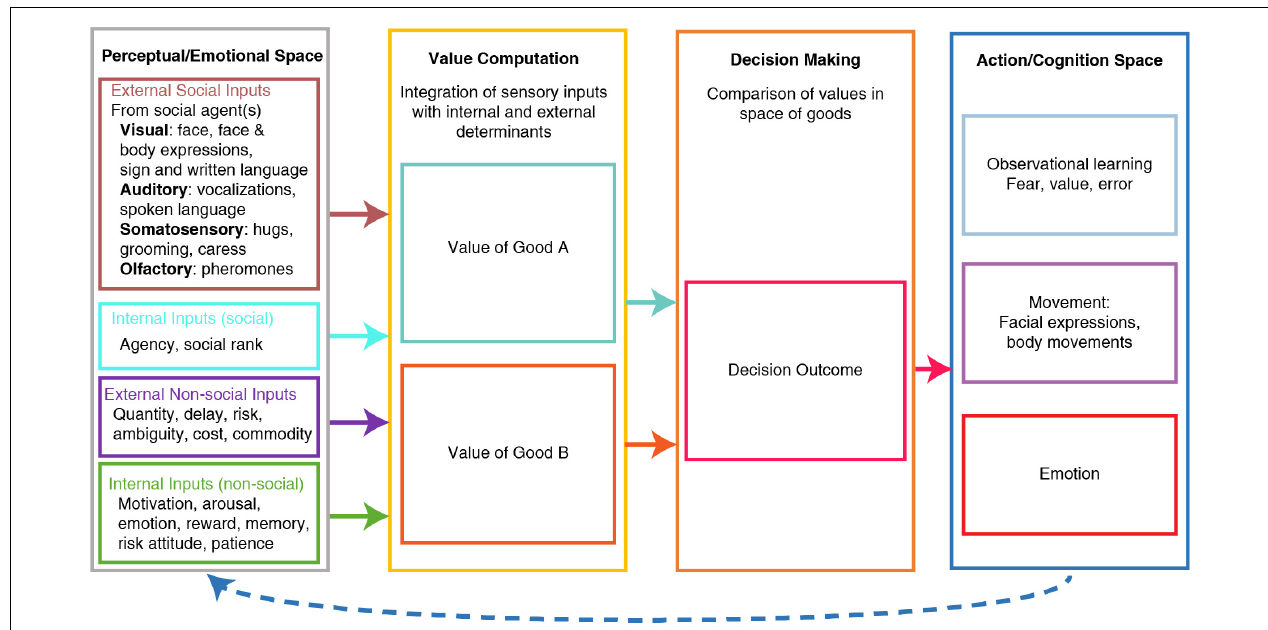
FIGURE 1 | Schema of Value-based social decision-making. Under this model, the value of each good is computed by integrating multiple types of information or determinants, some of which are external social & non-social determinants, while others are social & non-social determinants computed internally. The values of different goods are computed independently of each other and are compared to decide. The decision outcome guides an action plan through a good-to-action transformation. Values and choice outcomes inform future value computations through observational learning, emotion, and observed movements. Based on Padoa-Schioppa